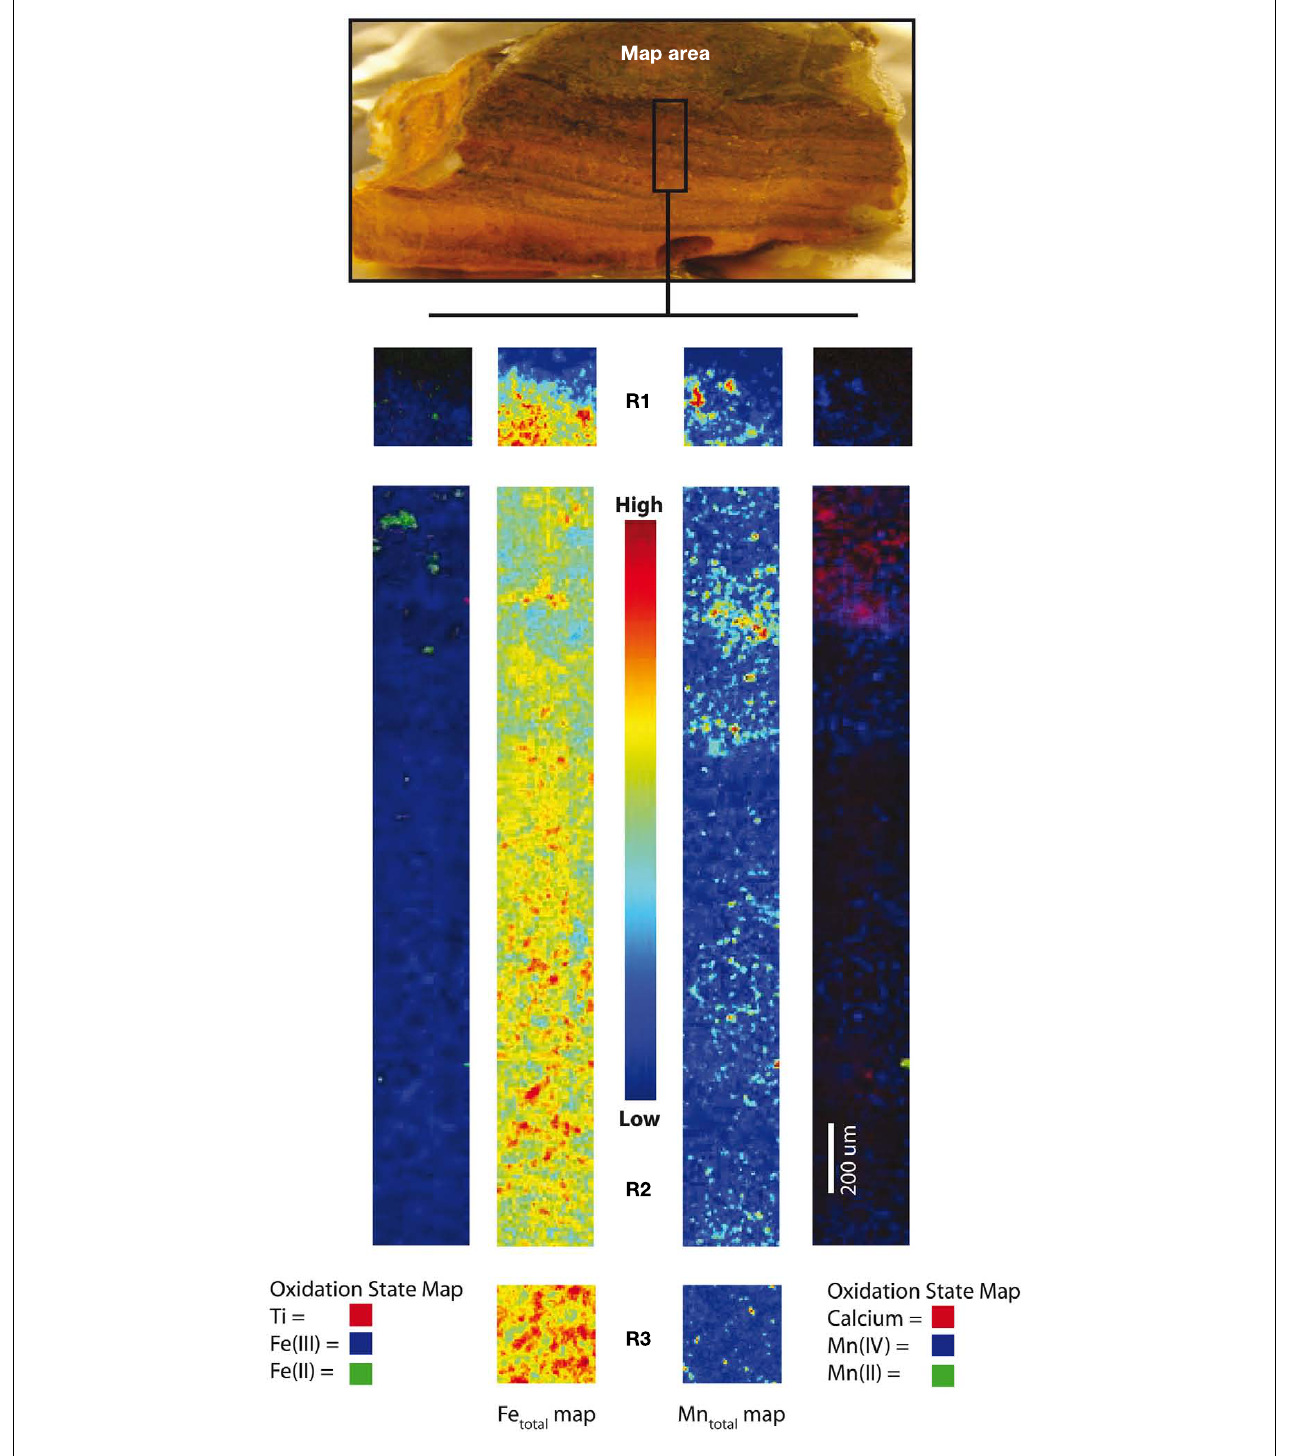
FIGURE 2 | X-ray microprobe fluorescence mapping of an intact Fe/Mn iron microbial mat from Ula Nui. Center maps for Regions 1, 2, and 3 (R1, R2, R3) show total Fe and Mn distributions, while outer